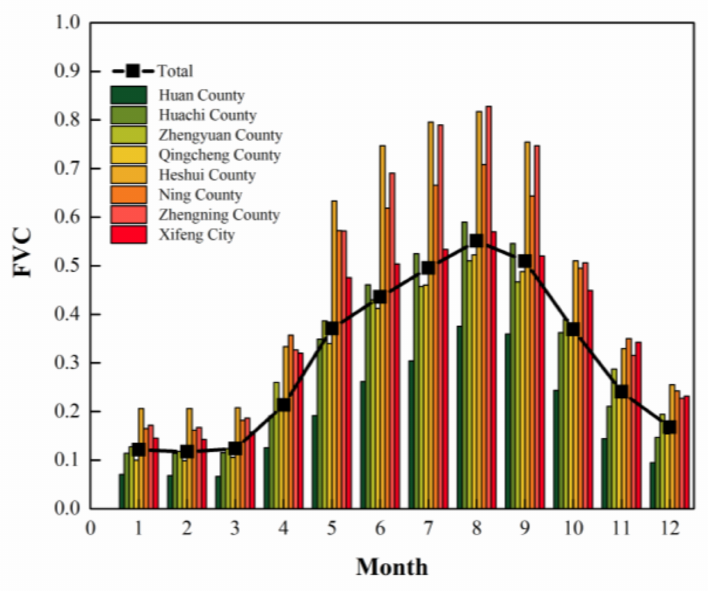
Figure 3. Seasonal pattern of FVC in